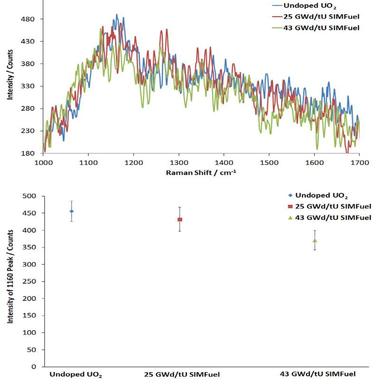
Average μRaman spectra recorded from undoped UO2, 25 GWd/tU SIMFuel and 43 GWd/tU SIMFuel samples over the range 1000 to 1700 cm−1 (top) and the fitted intensity of the 1160 phonon peak from undoped UO2, 25 GWd/tU SIMFuel and 43 GWd/tU (bottom).